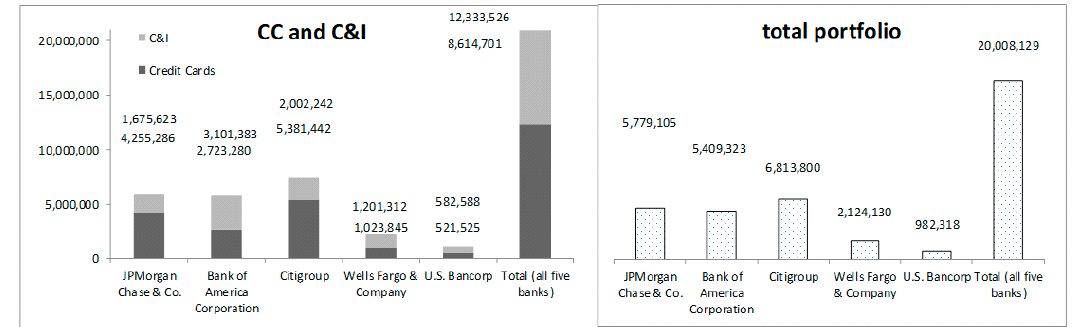
Table 6. Nominal unexpected losses—simulation results.